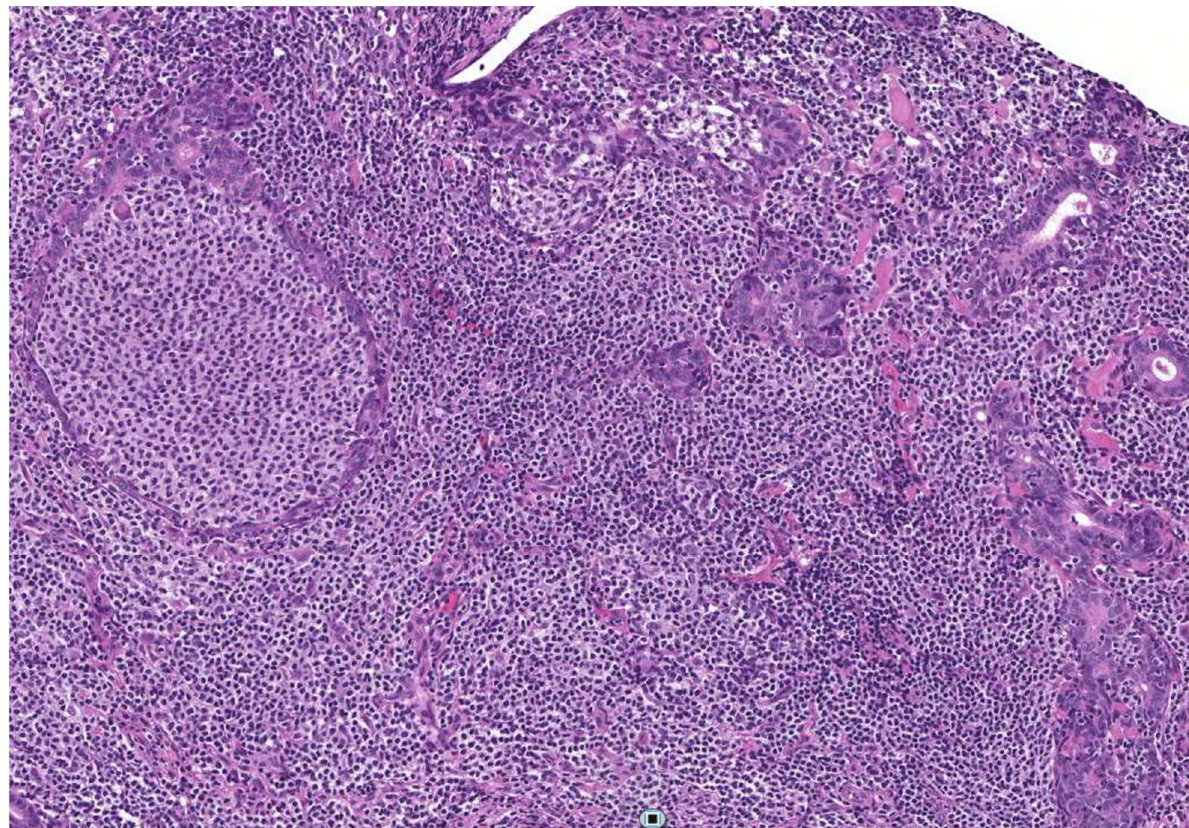
Figure 2. Histological picture showing a marginal zone lymphoma of the MALT type in a parotid gland characterized by diffuse coalescence of centrocyte-like lymphocytes with lymphoepithelial lesions (H&E, 200×).